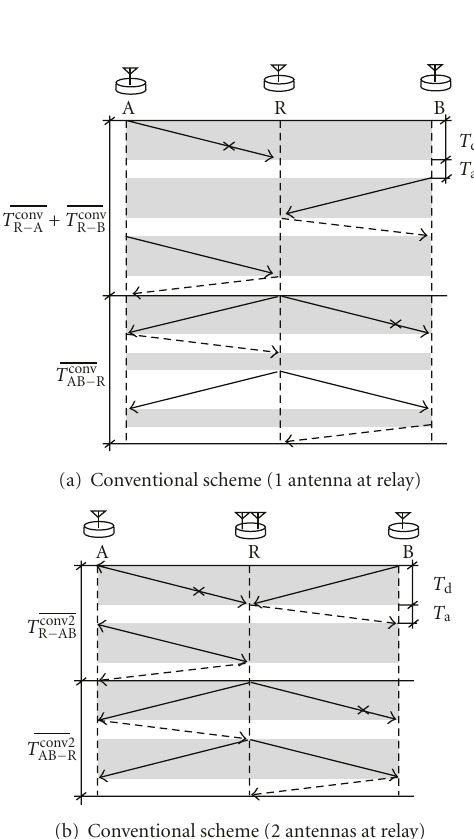
Figure 8: Network coding header.